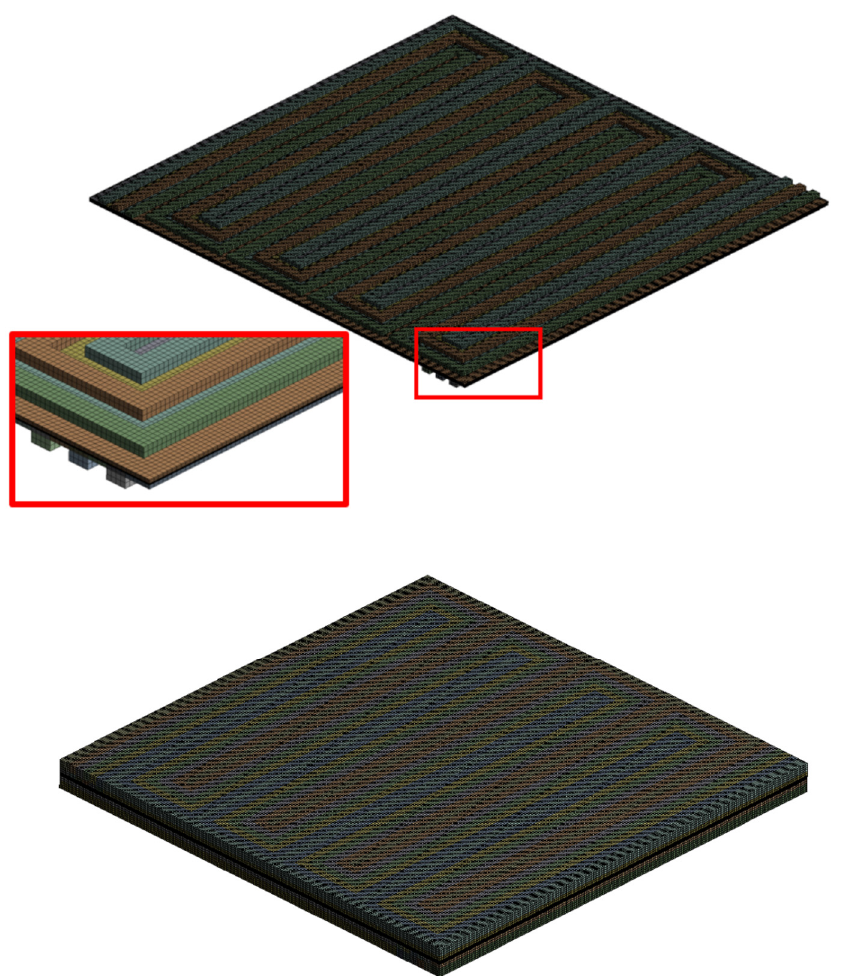
Figure 4. Finite volume mesh of the channels ( above ) and detail of MEA cross section (red rectangle) and the entire domain ( below ).